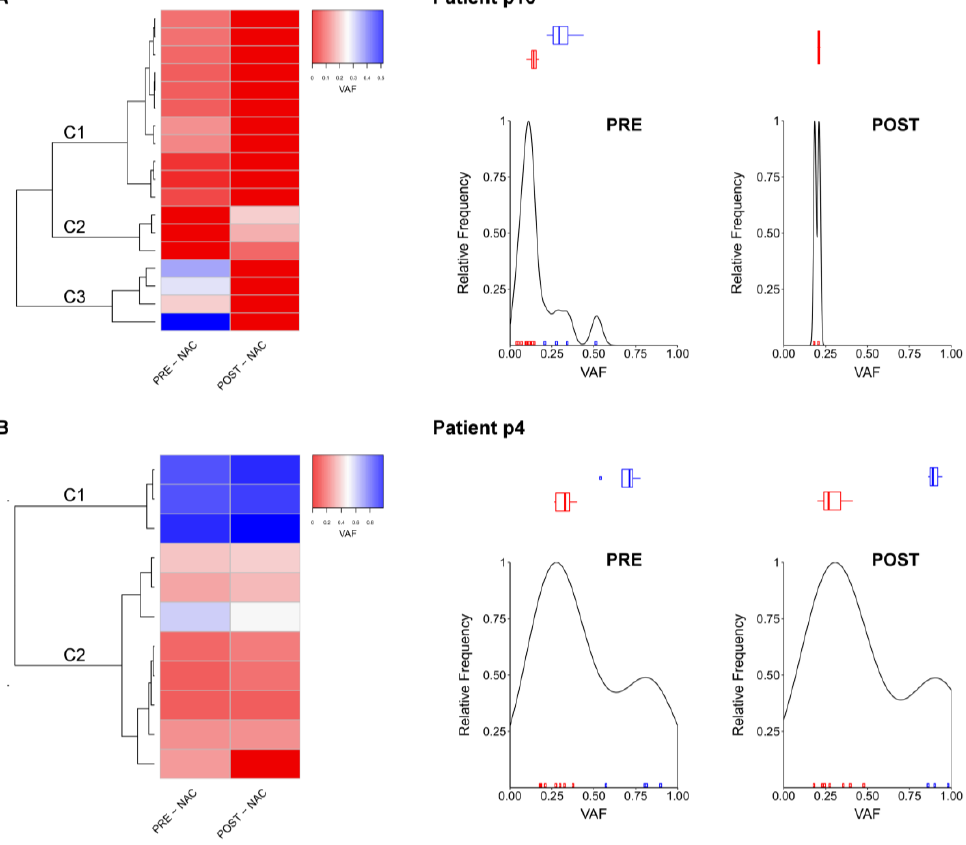
Figure 3. Evaluation of mutant allele distribution between matched pre- and post-NAC samples. Non-synonymous mutations of representative patients with residual mutations in post-NAC samples ( A ) and without evidence of change from post-NAC samples ( B ) are grouped and represented in red-blue scale according to their